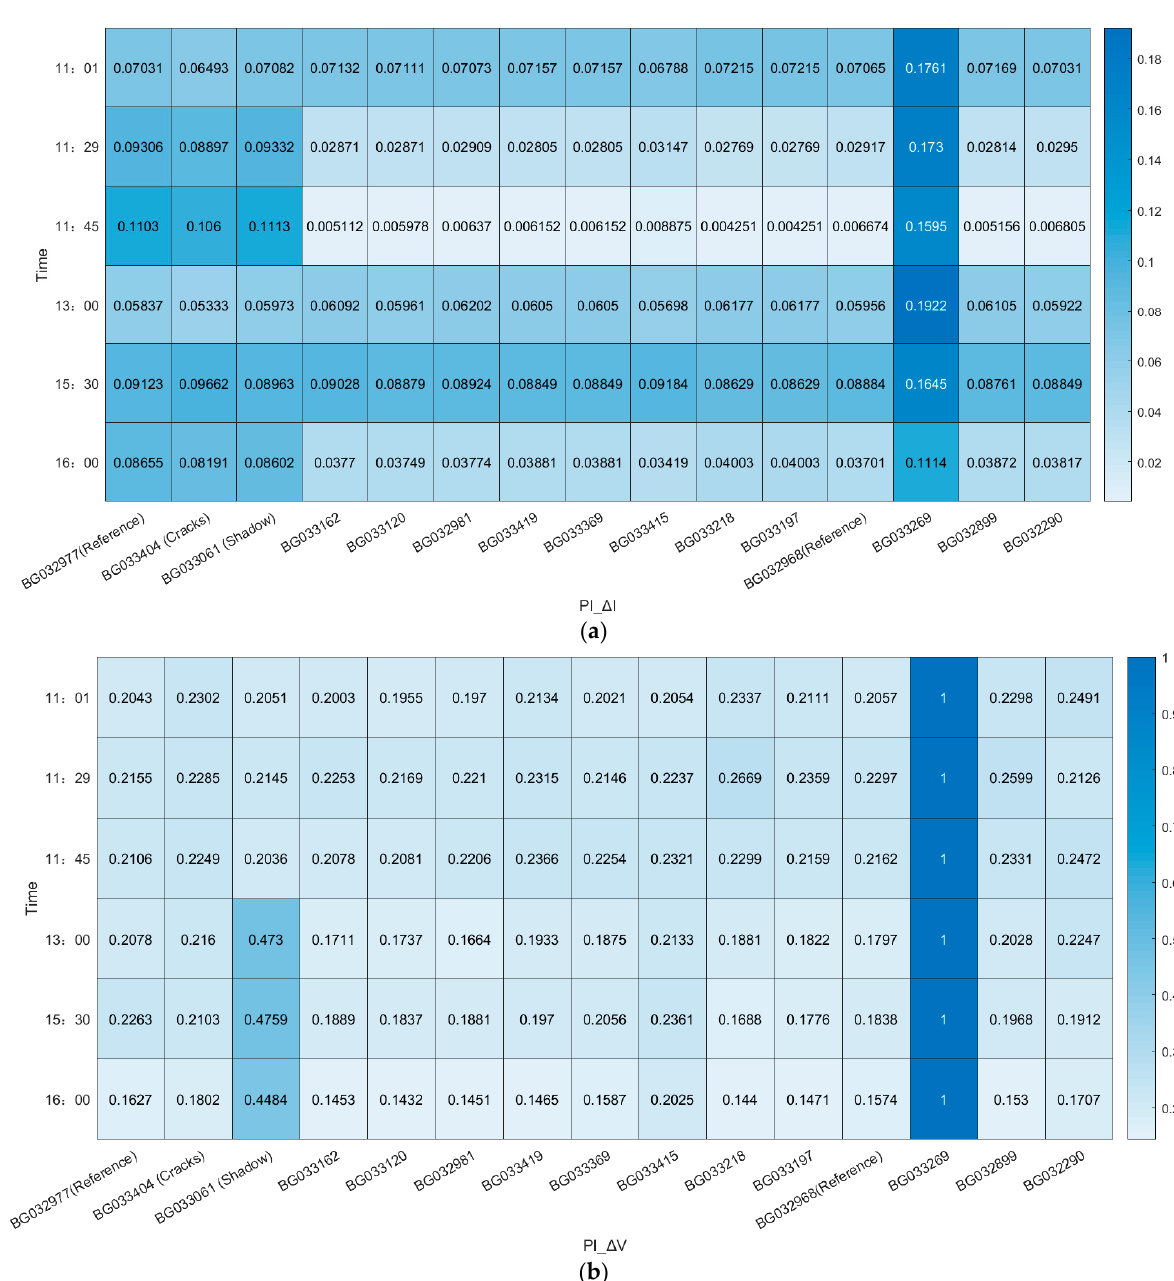
Figure 15. Performance indicators of individual PV module in PV strings: ( a ) performance indicator in current; ( b ) performance indicator in